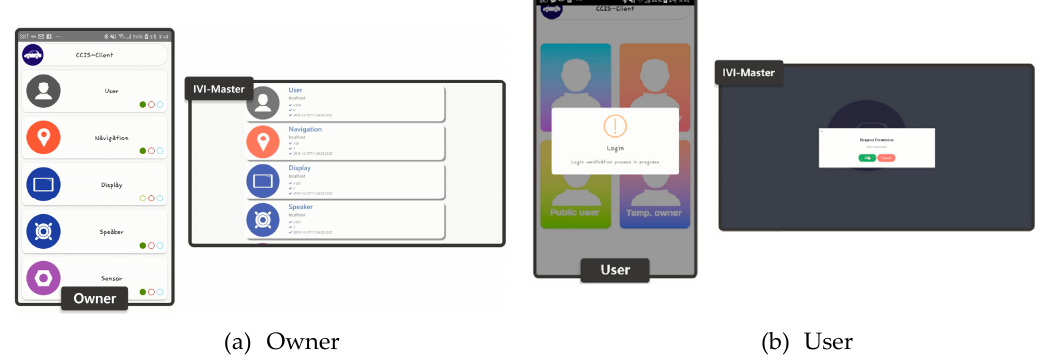
Figure 15. Screen captures for resource list requests from owner and user.